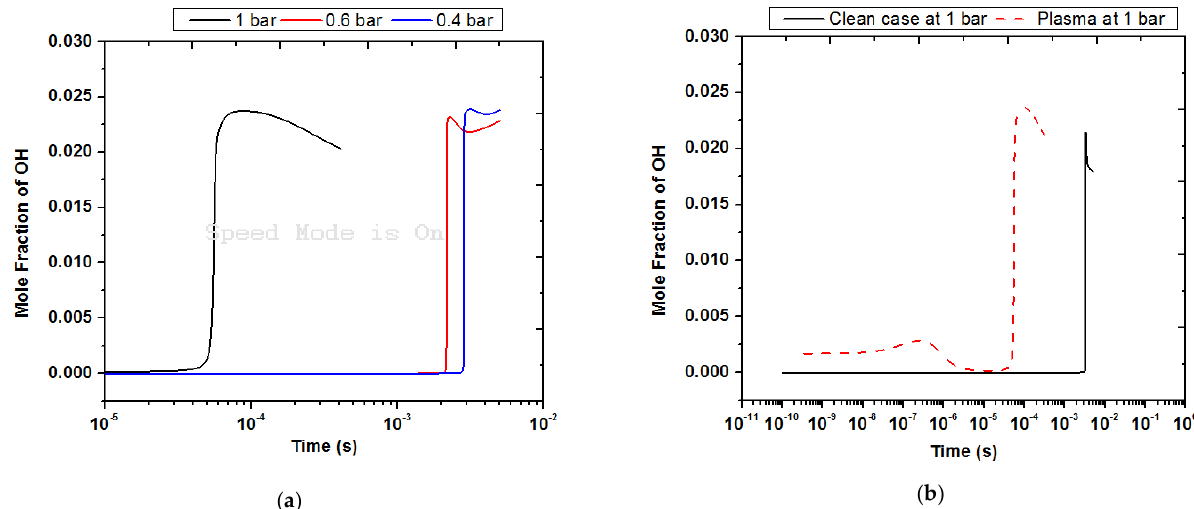
Figure 13. Maximum molar fraction of OH concentration achieved at certain period of time ( a ) dif- ferent inlet pressures during the plasma discharge; ( b ) with or without the plasma discharge at 1 bar.